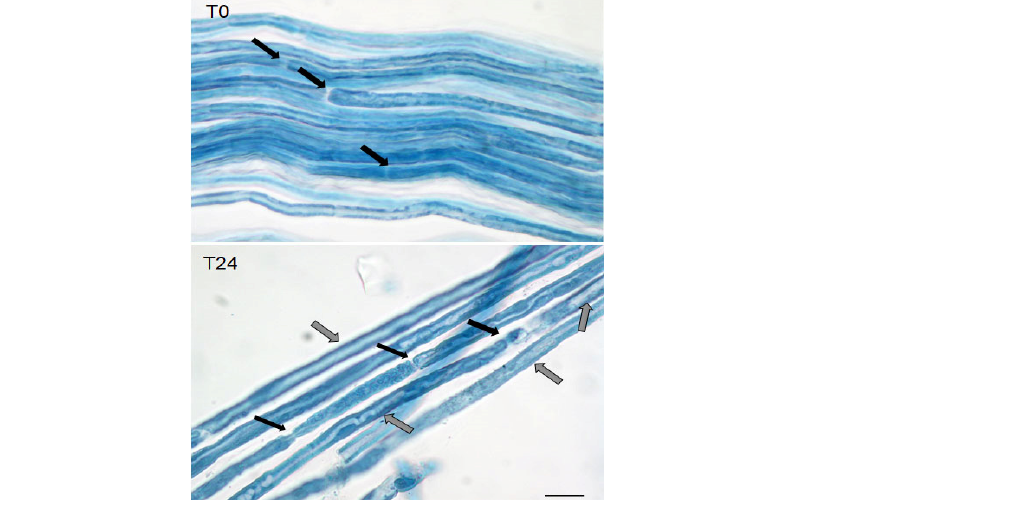
pressed in SCs under basal conditions, but their expression significantly increased upon 10 μ M BK treatment (Figure 2D,E).